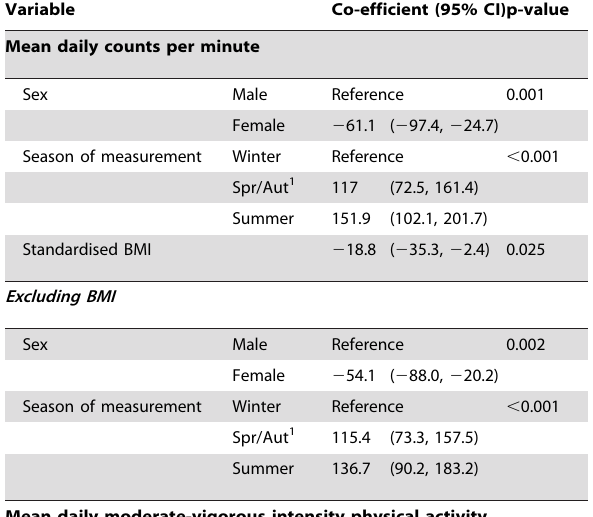
Table 3. Results of adjusted regression analyses showing coefficients for all variables having at least one significant unadjusted association with an outcome